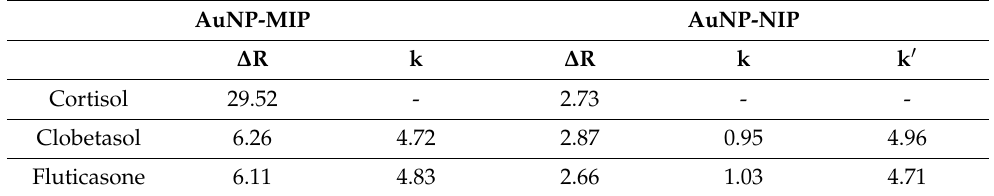
Table 1. Selectivity (k) and relative selectivity (k (cid:48) ) coefficients of plasmonic sensors.